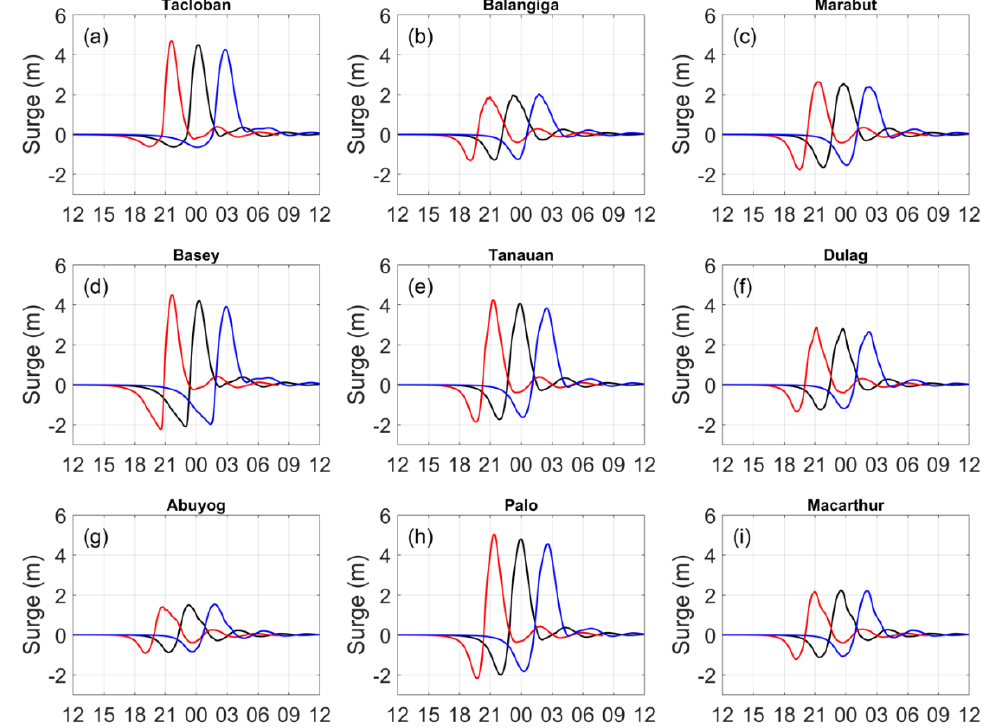
Figure 17. ( a – i ) Time series of the computed storm surges in the numerical experiment on a storm forward motion: original speed ( black lines ), increased forward speed ( red lines ), and decreased forward speed ( blue lines ) in the numerical gauges. The detailed information of numerical gauges can be found in Figure 2b and Table 2. The x -axis indicates the time from 12:00 UTC 7 November 2013 to 12:00 UTC 8 November 2013.